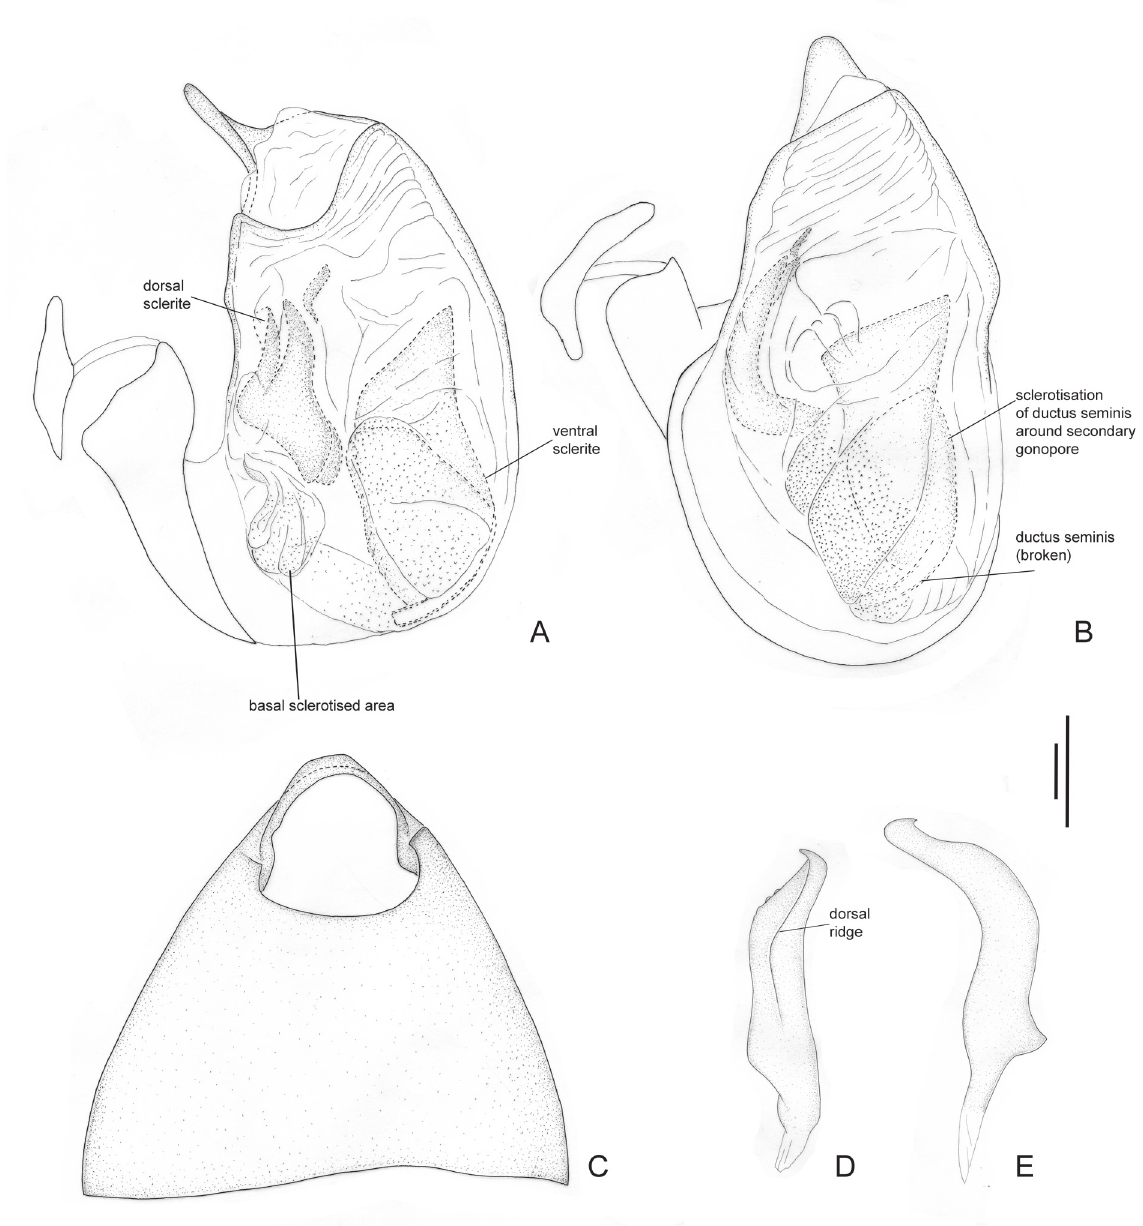
Fig. 8. Genitalia of C. ovatum sp. nov. A . Aedeagus, left lateral view. B . Aedeagus, ventral view. C . Genital capsule. D . Right paramere. E . Left paramere. Scale bars = 0.1 mm (the large scale bar is for A–B and D–E, the small scale bar is for